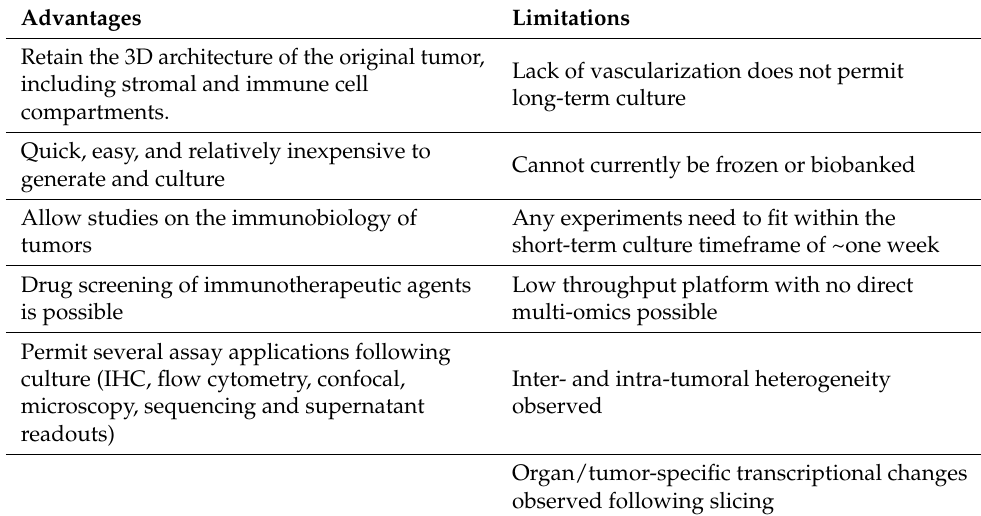
Table 2. Main advantages and limitations of